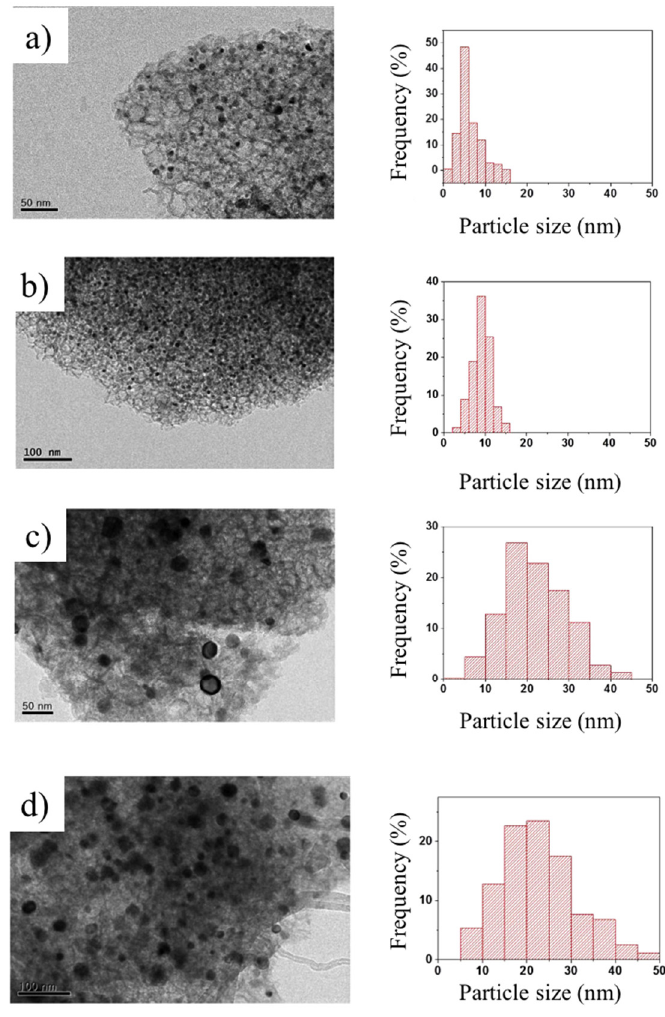
Figure 7. TEM image and size distribution of Ni nanoparticles synthesized on mesoporous silica via PET assisted impregnation method ( a ) before and after ( b ) DRM reaction (denoted as Ni/PST in Ref. [82]). TEM image and size distribution of Ni nanoparticles synthesized on mesoporous silica via classical impregnation method ( c ) before and ( d ) after DRM reaction (denoted as Ni/ST in Ref. [82]). Reprinted with permission from Ref. [82]. Copyright (2017) Elsevier.